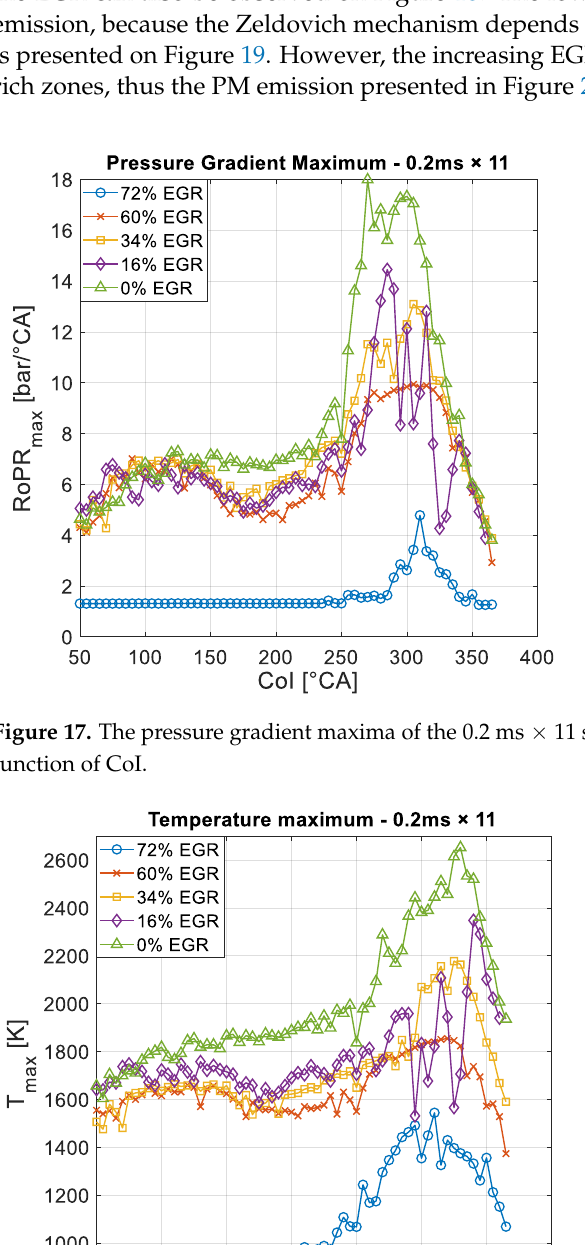
Figure 16. The center of heat release of the 0.2 ms × 11 structure with different EGR rates in the function of CoI.